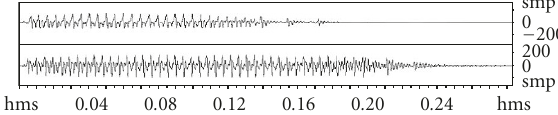
Figure 11: Waveform of clean vowel /O/ (upper) and Lombard vowel /O/.